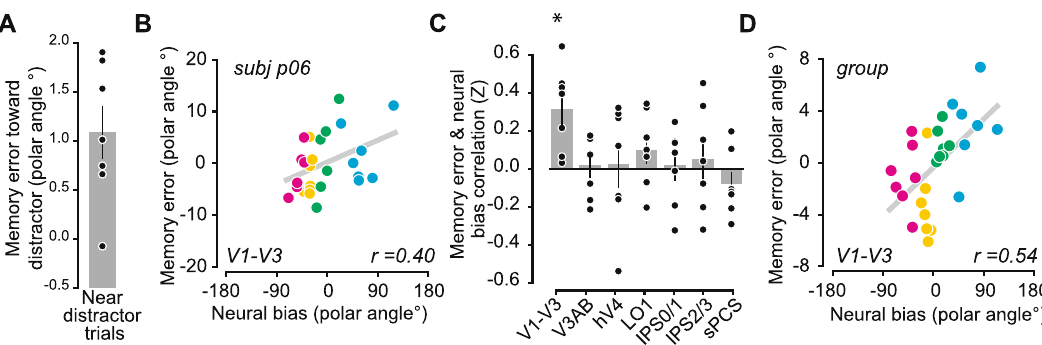
Fig. 7 Memory errors correlate with distractor-induced biases in WM representations in visual cortex. A On distractor-present trials in which the distractor was presented within 12° polar angle from the WM target, we found an attractive bias such that behavioral WM responses were drawn toward the distractor (positive values indicate errors in the same direction as distractor; two-tailed permutation t -test, p = 0.006). B We quanti fi ed the trial-by- trial error of each WM reconstruction based on its circular mean (see Methods section) during the post-distractor epoch on distractor-present trials when the distractor was presented near the WM location. To determine whether behavioral WM responses were impacted by any offsets in these neural WM representations, for each ROI and participant we correlated each trial ’ s decoded WM representation error with the corresponding behavioral memory error. Example scatterplots shown for one participant and ROI; trend line shows least squares linear fi t (all participants and ROIs are plotted in Supplementary Fig. 6). C Average (±SEM) neural/behavioral error correlation across participants based on decoded error from each ROI. Behavioral responses signi fi cantly correlated with errors in neural representations in V1 – V3, but not other ROIs ( p = 0.005, FDR corrected across ROIs; trial-level permutation test; see Methods section). There was no signi fi cant main effect of ROI ( p = 0.08, permuted 1-way ANOVA). All p-values available in Supplementary Table 8. D Additionally, we sorted each trial into quartiles based on each neural bias and subsequently took the mean of neural bias and behavioral memory error within each group of trials per participant. Then, we computed the Pearson correlation coef fi cient using these binned data (one mean per participant per quartile, 28 data points total). Asterisks denote signi fi cant results, p < 0.05, FDR